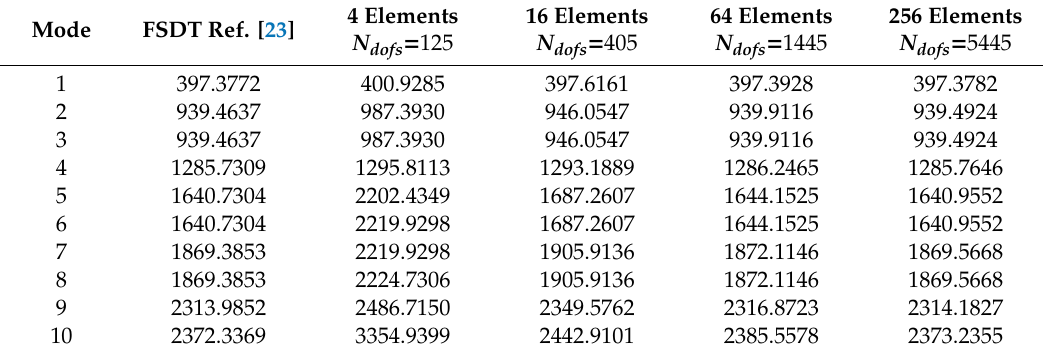
Table 4. Convergence features of the numerical approach and comparison of the first ten natural frequencies (Hz) with the semi-analytical solutions provided by Reddy [23] for a simply-supported thick plate with a through-the-thickness uniform distribution of the reinforcing fibers. FSDT: first-order shear deformation